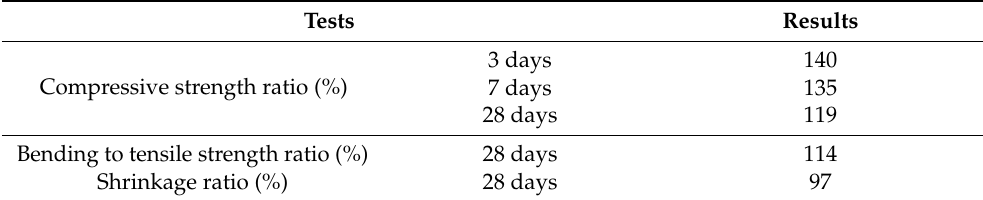
Table 4. Experimental results of naphthalene ZH-3 air-entraining superplasticizer.